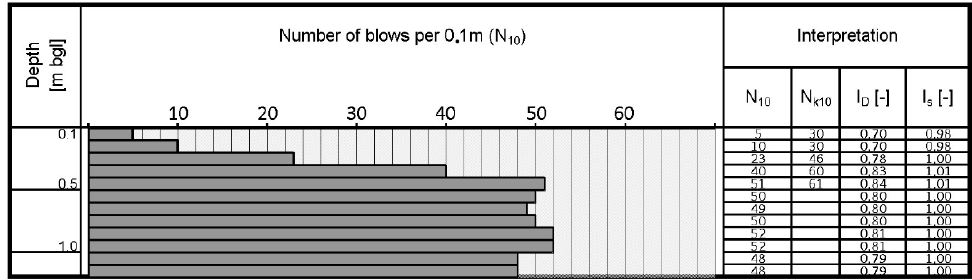
Figure 13. Dynamic probe profile.